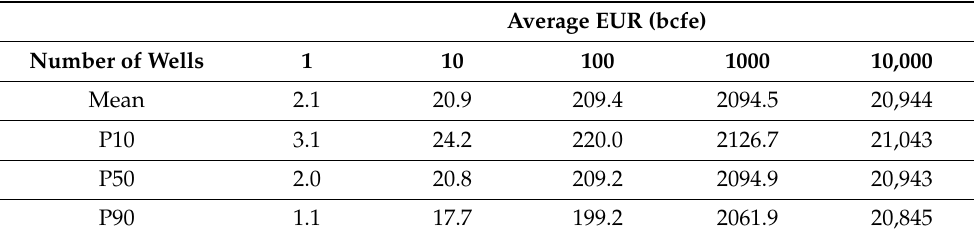
Table 9. Summary of the simulated results of the drilling